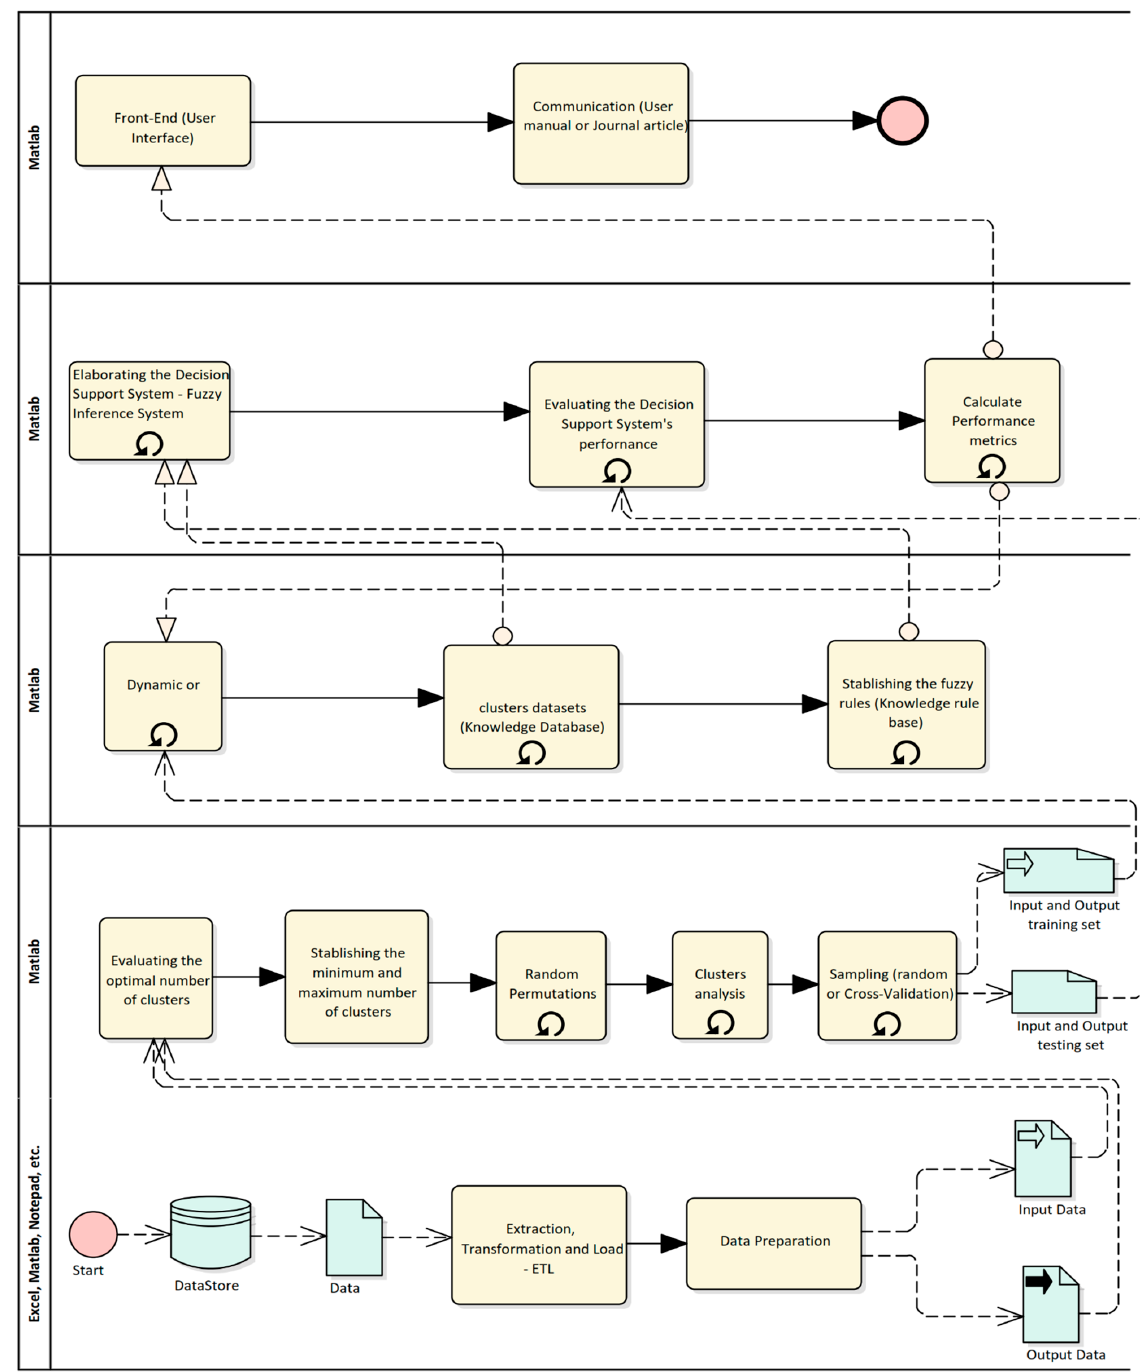
Figure 1. The proposed five layers architecture framework. Source: Own elaboration.